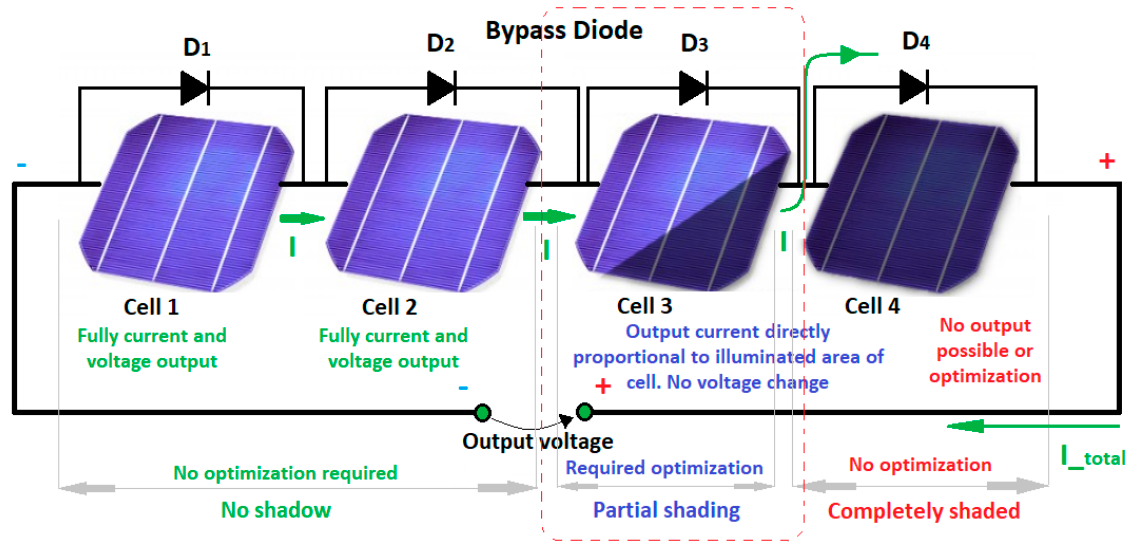
Figure 1. The shading effect on photovoltaic modules.